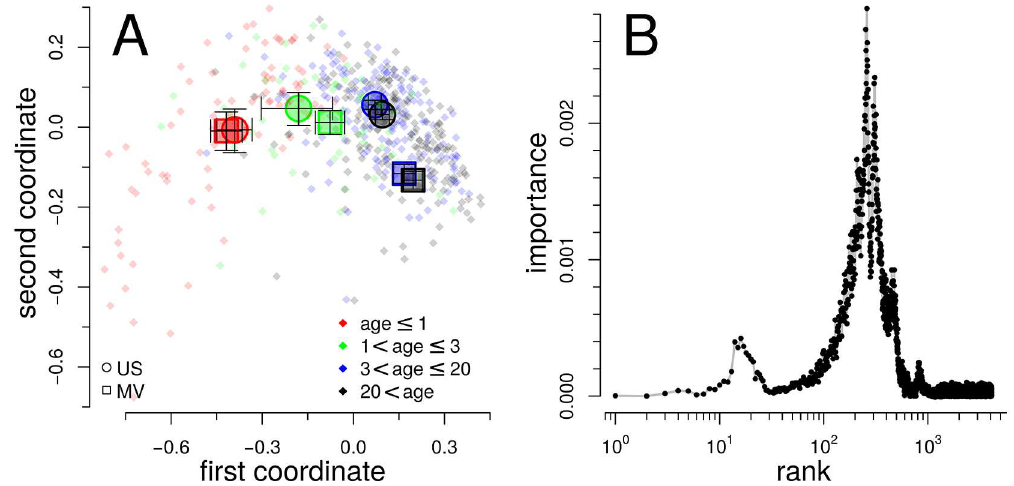
Fig 7. Country of origin and age as determinants of gut microbiomes NRADs. (A) MDS-ordination of NRADs of those 489 gut microbiomes from Malawi/Venezuela(MV) and United States (US) with age information. Small symbols represent individual NRADs, large symbols are averages. Error bars are 90% confidenceintervals of the averages. The two coordinates of the MDS plot explain83% of the NRAD distances. (B) Importance of each of the 4105 NRAD ranks for the random forest classificationaccordingto country of origin (MV vs. US). The two peaks aroundranks 20 and 200 are the NRAD regions that carry most informationabout the country of origin.